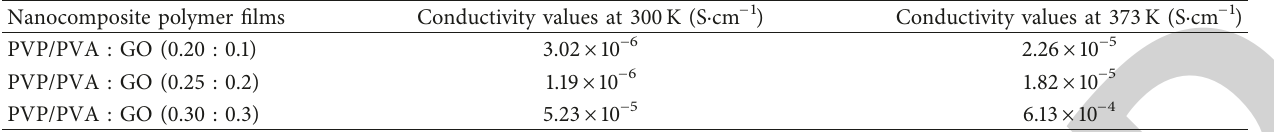
Table 3: DC conductivity values of PVP/PVA : GO nanocomposite polymer films. Nanocomposite polymer films